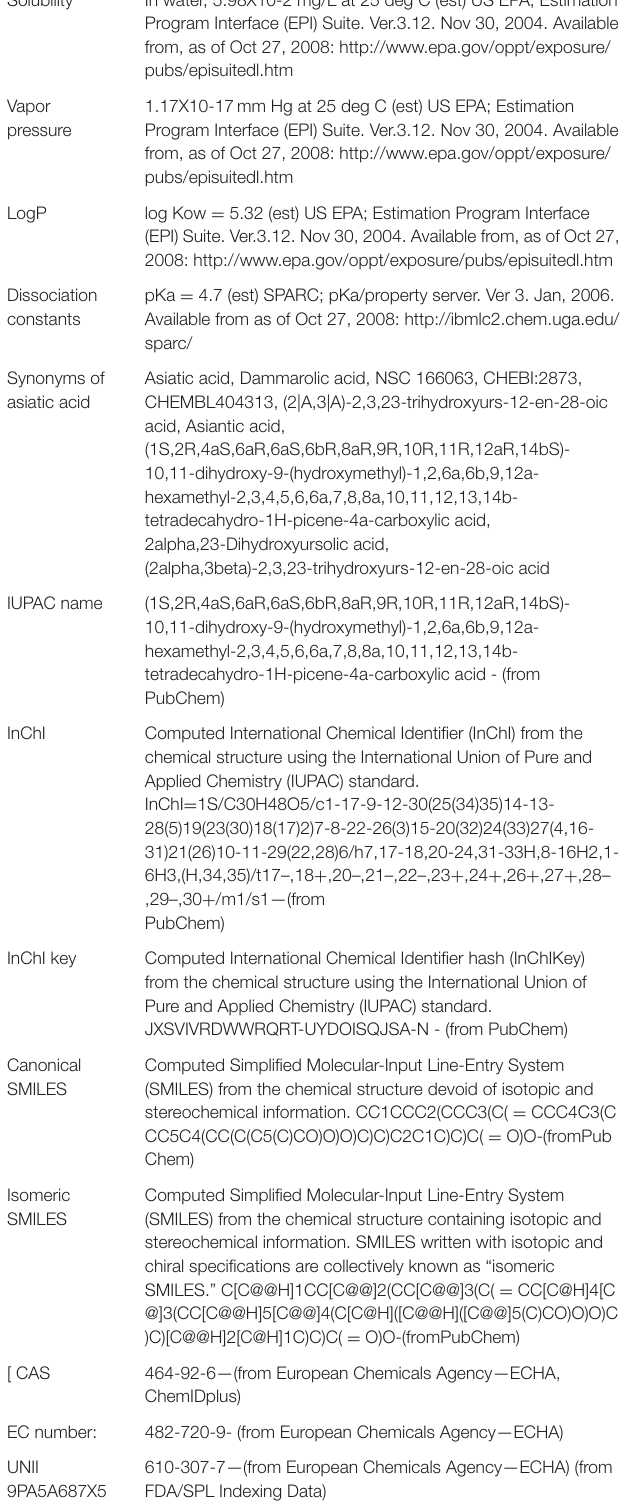
TABLE 2 | Physical properties and synonyms of asiatic acid.